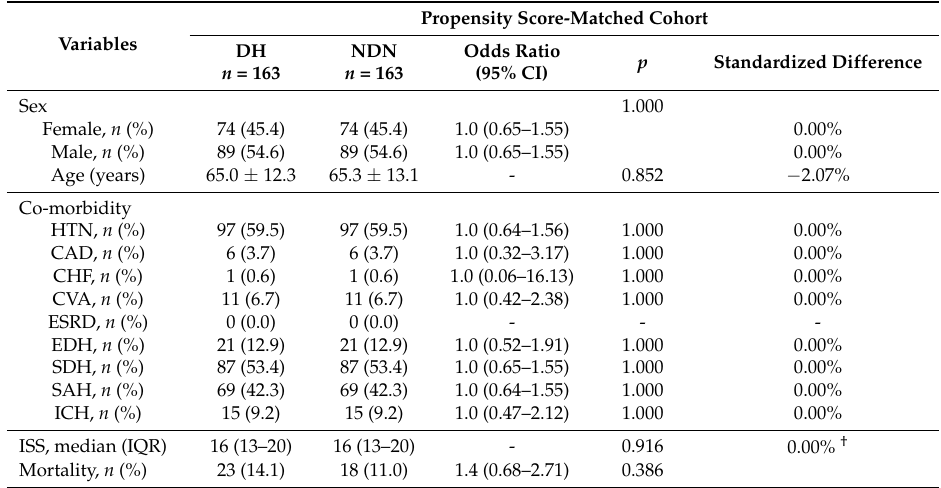
Table 4. Comparison of mortality outcomes in the selected propensity-score matched cohort of DH and NDN groups of